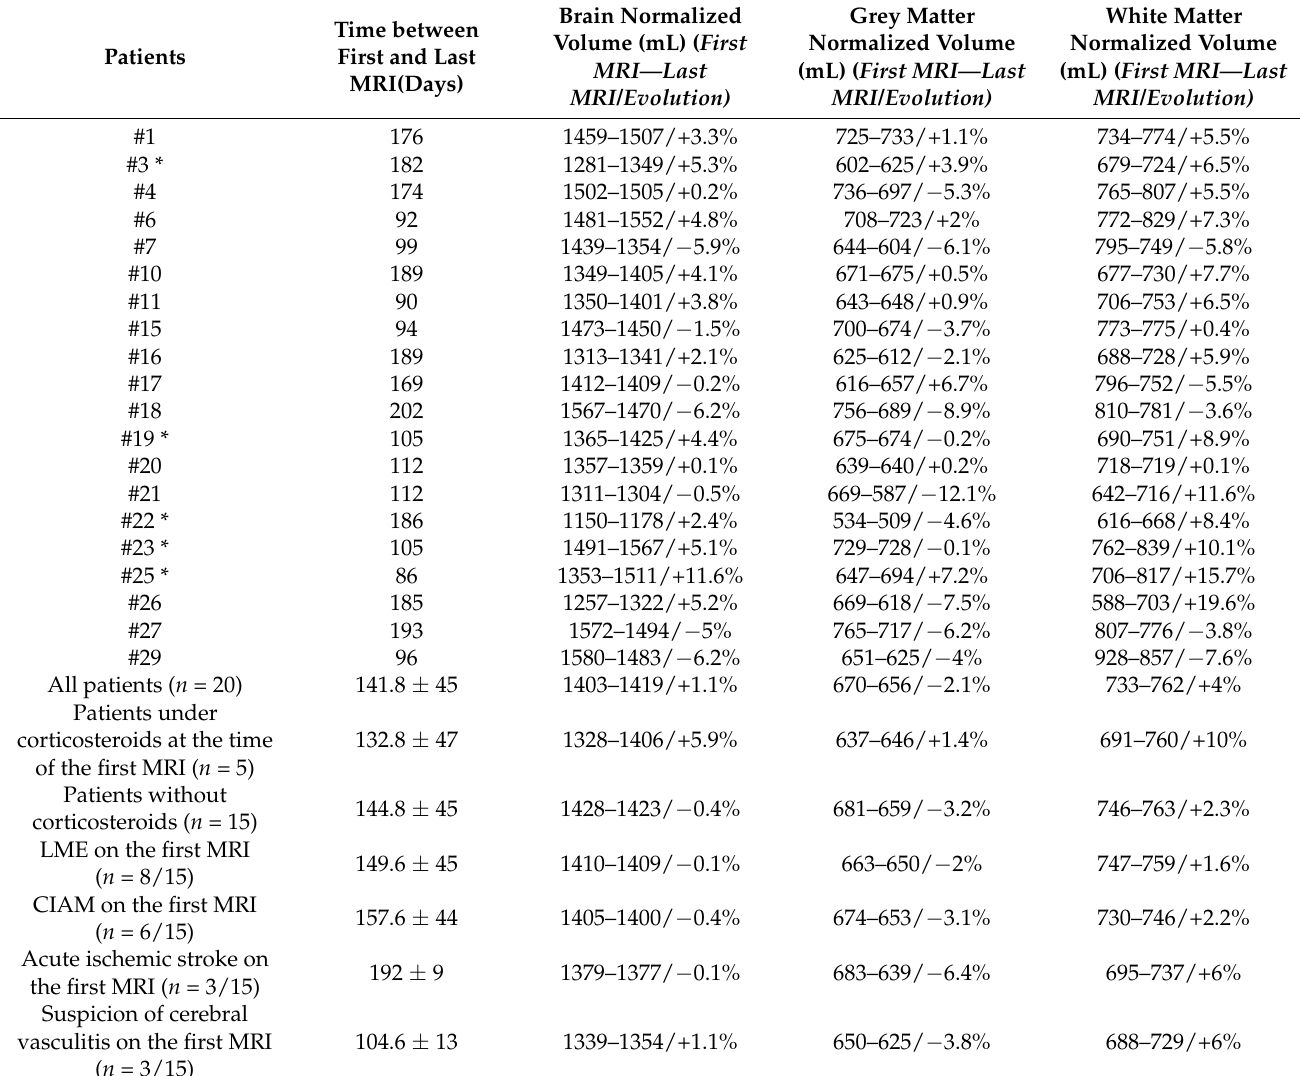
Table 2. Brain volumetry